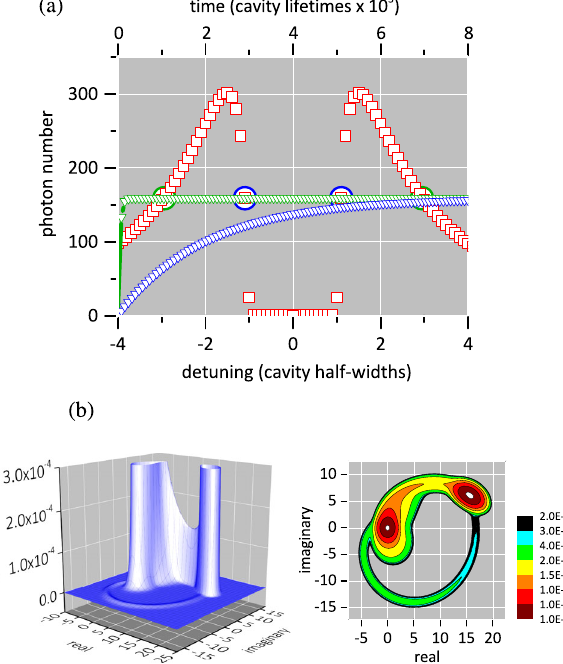
FIG. 3. (a) Mean photon number in steady state versus drive detuning Δ ω = κ for drive amplitude E = κ ¼ 18 (red squares). Additional curves show the time evolution to the steady state for Δ ω = κ ¼ (cid:2) 1 . 1 (blue triangles and blue circles) and Δ ω = κ ¼ (cid:2) 2 . 95 (green triangles and green circles); the time axis appears at the top of the graph. (b) Surface plot and contours of the steady- state Q function for Δ ω = κ ¼ þ 1 . 1 ; peak heights are h 1 ¼ 0 . 12 (left peak) and h 2 ¼ 0 . 14 (right peak).